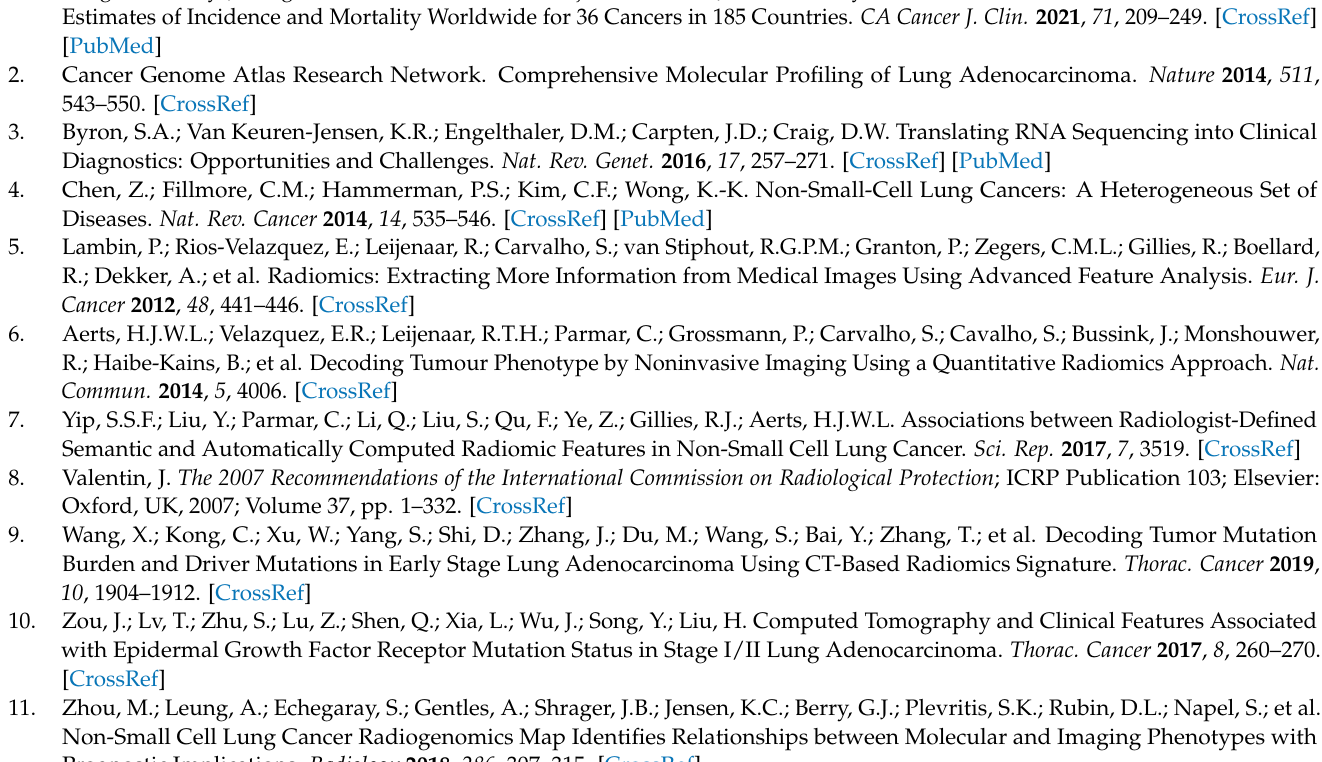
Figure S3: The entire heatmap for Spearman correlation analysis; Table S1: Case IDs of patients used in the training dataset; Table S2: Case IDs of patients used in the test